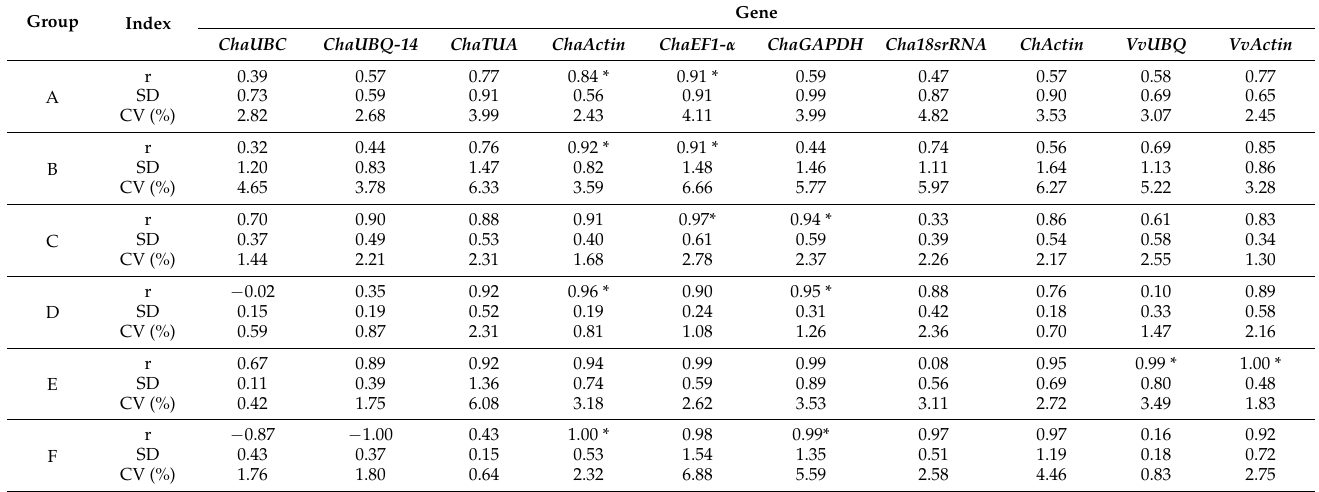
Table 5. Stability analysis of 10 candidate reference genes using